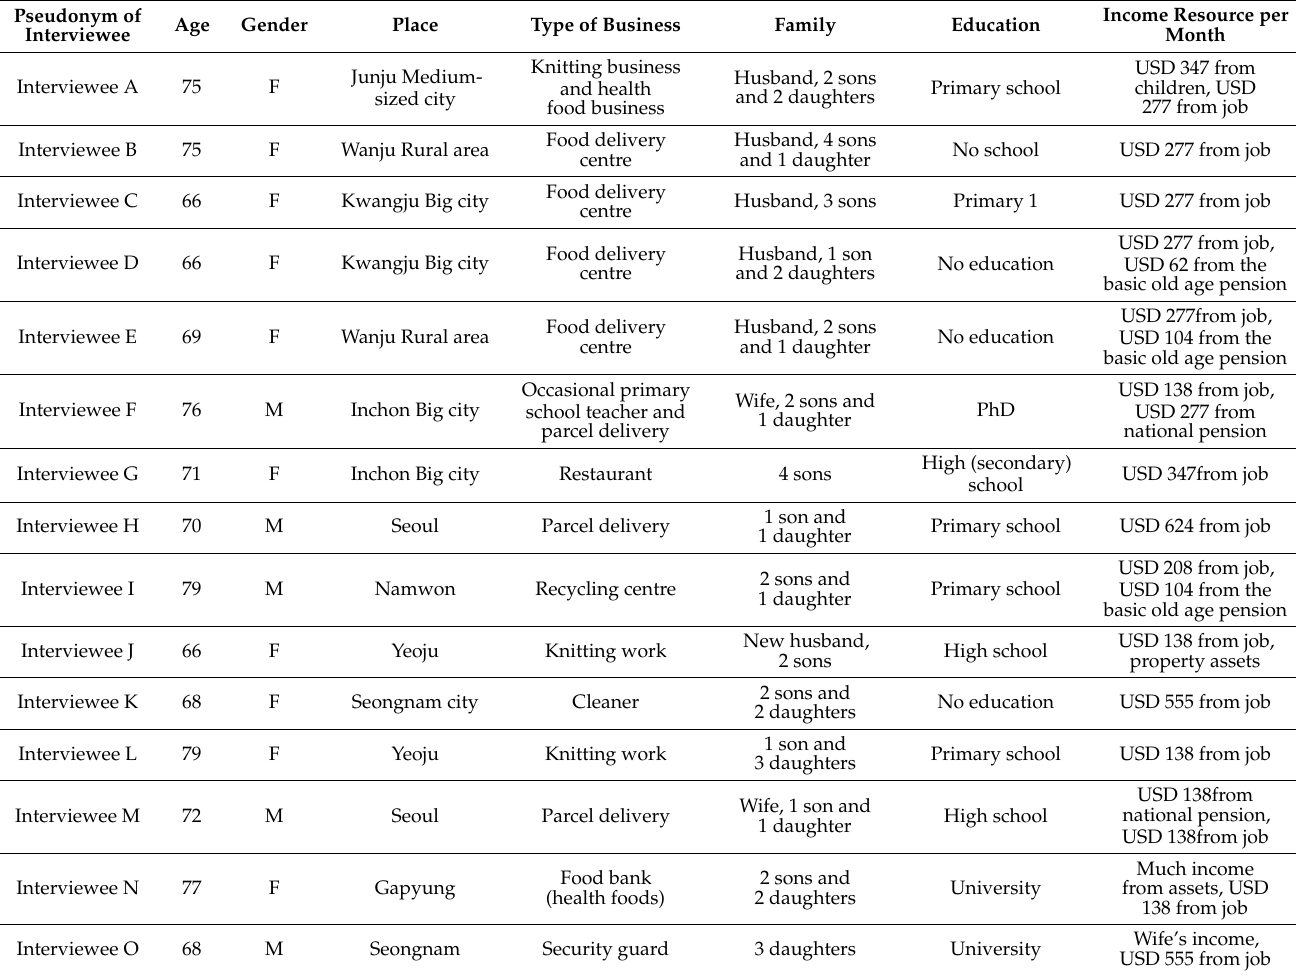
Table 1. A summary of the personal data in the research